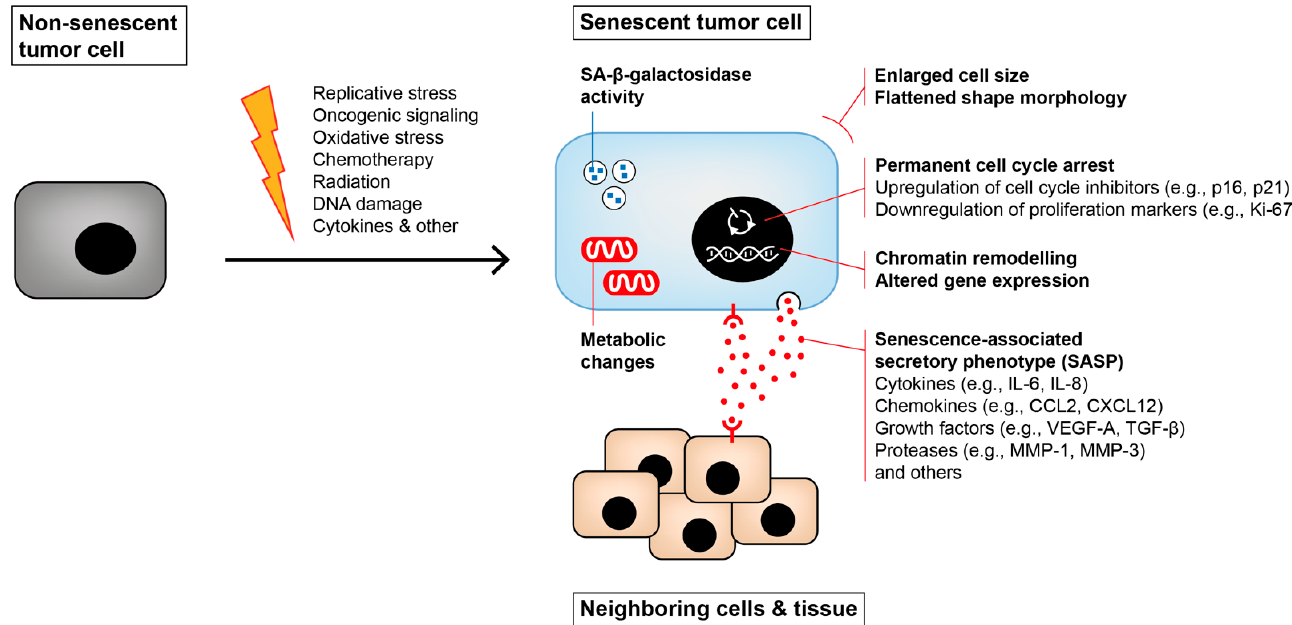
Figure 4. Senescence induction and its impact on neighboring cells. After encountering a senescence trigger (orange lightning), the cells start to change. They adopt a flattened morphology and enlarge in size. Besides being growth-arrested, the cells show increased activity of the senescence-associated β -galactosidase (SA- β -gal), metabolic changes, chromatin remodeling and an altered gene expression, including the formation of a senescence-associated secretory phenotype (SASP). This SASP then acts in an autocrine or paracrine manner, influencing the senescent cells themselves as well as neighboring cells in the tissue.